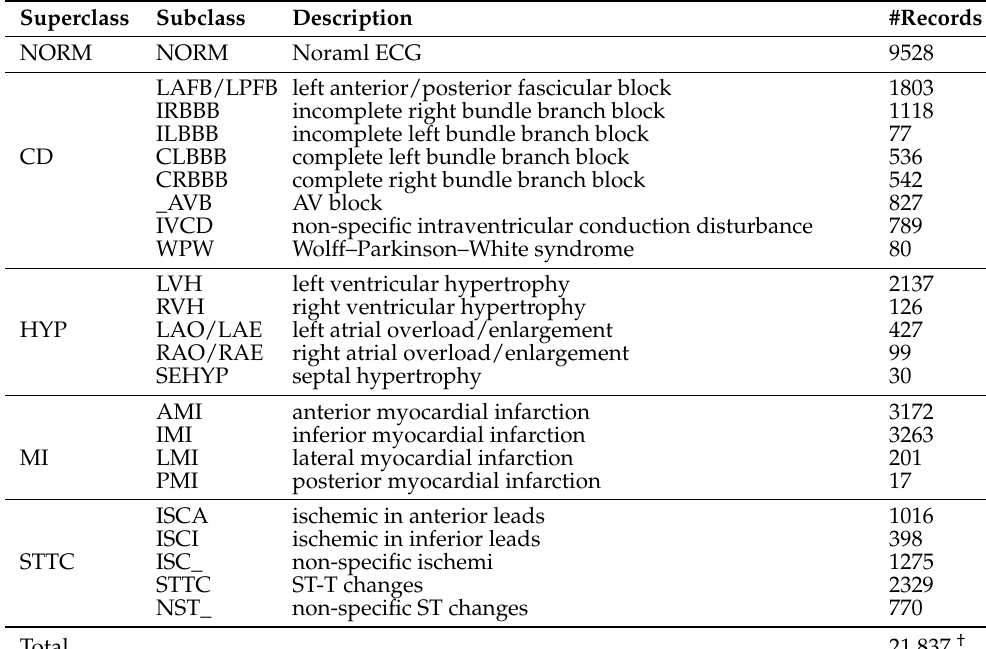
Table 2. ECG classes and their numbers in the PTB-XL